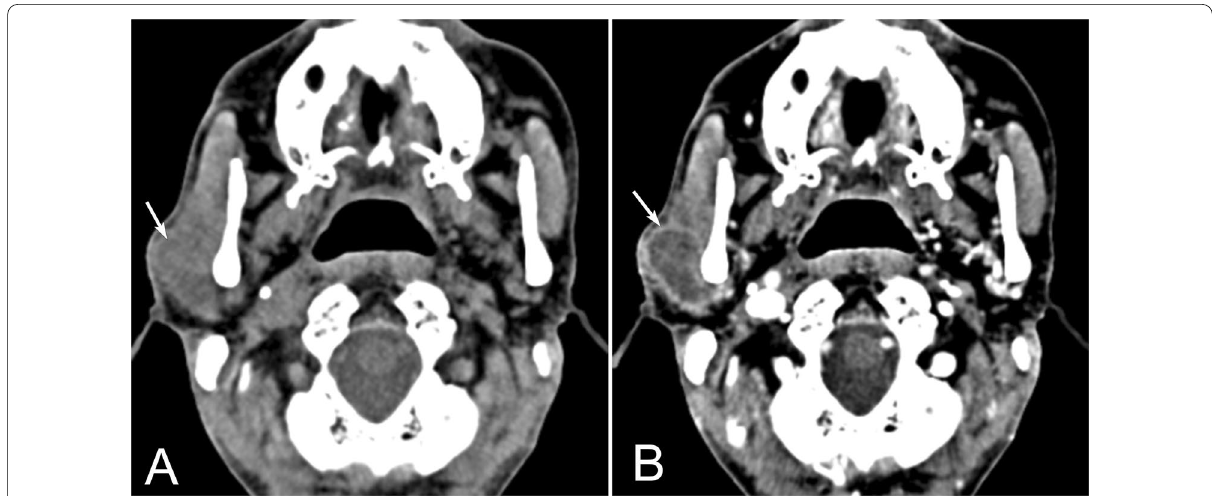
Fig. 3 A 65 years old male with primary parotid SCC in the right parotid gland. Axial non-contrast CT ( A ) shows an ill-defined, lobulated and hypodense lesion in the superficial part of the right parotid gland (arrow). Contrast-enhanced CT ( B ) demonstrates moderate rim enhancement with severe central necrosis (arrow)